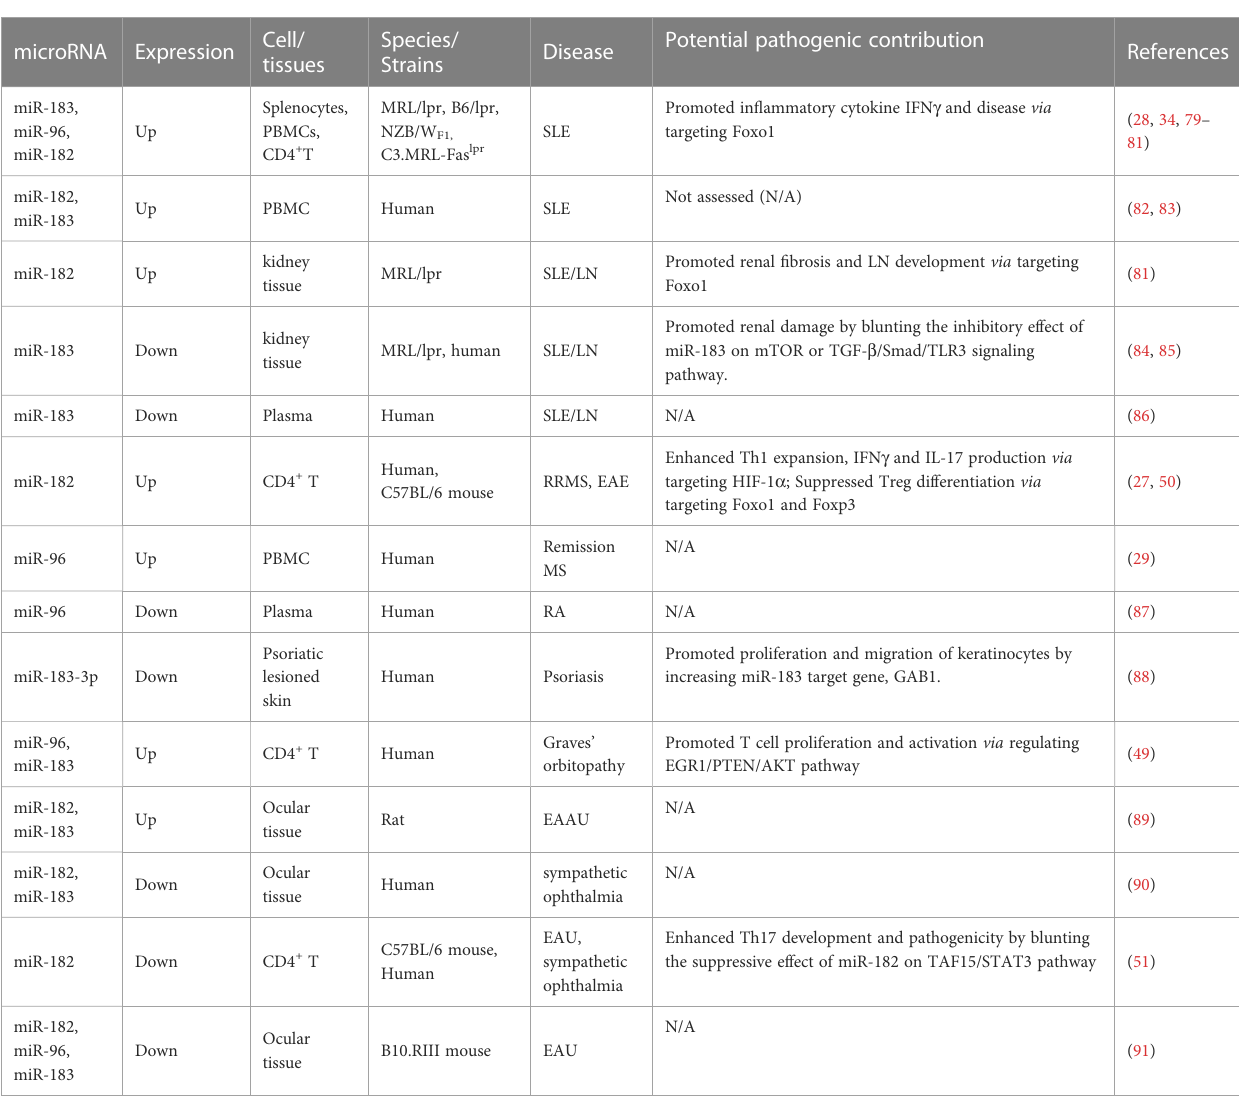
TABLE 1 Dysregulation of miR-183C in autoimmune diseases.